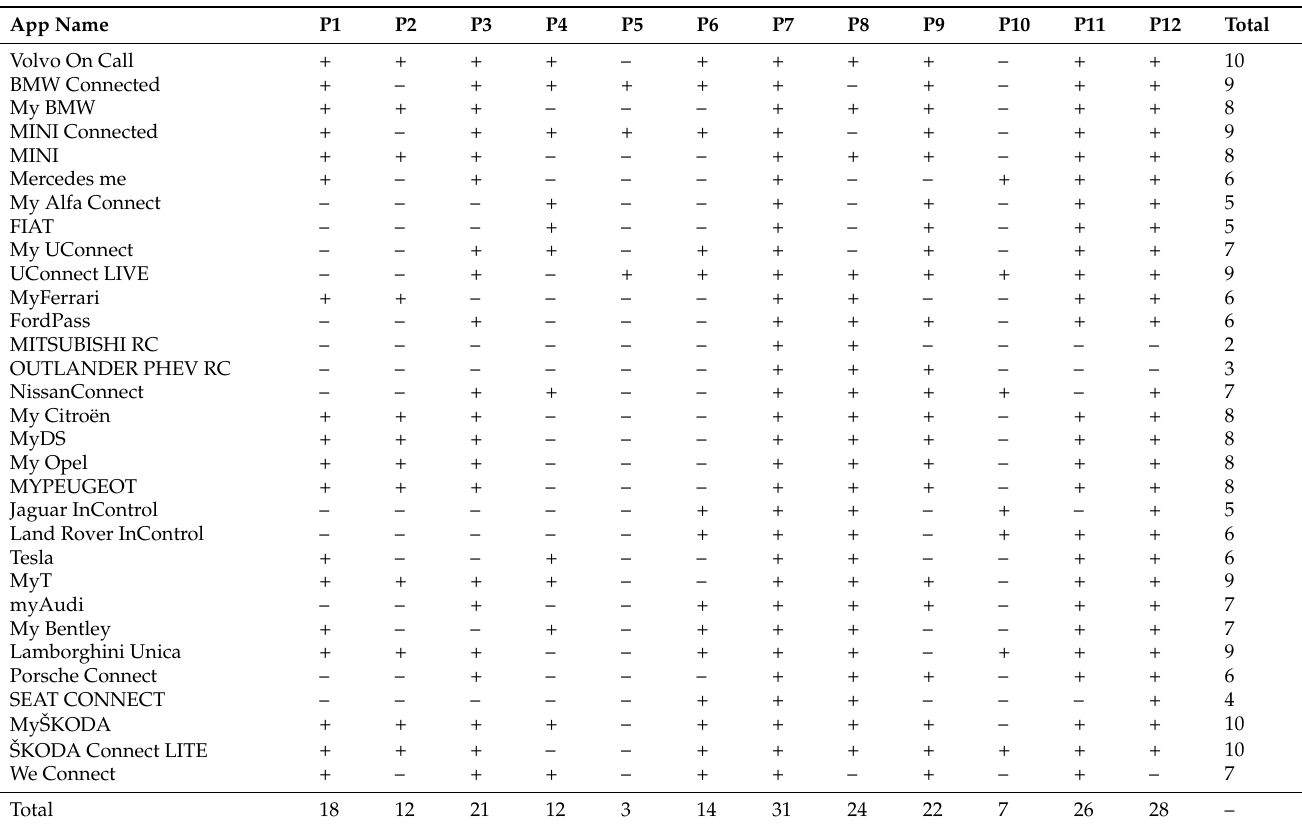
Table 2. Dangerous, according to the API, permissions requested by each